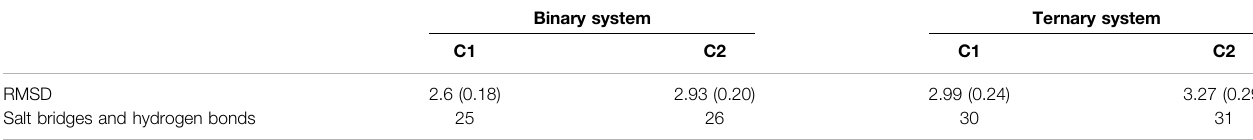
(cid:129) SOS cat interface in the binary and ternary systems a .